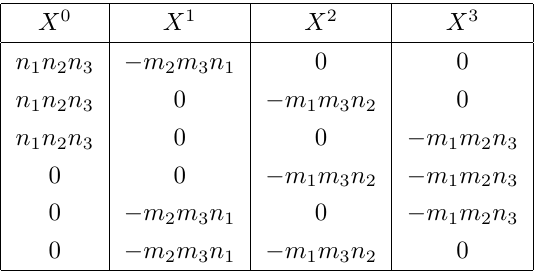
Table 1 . Possible winding number combinations for